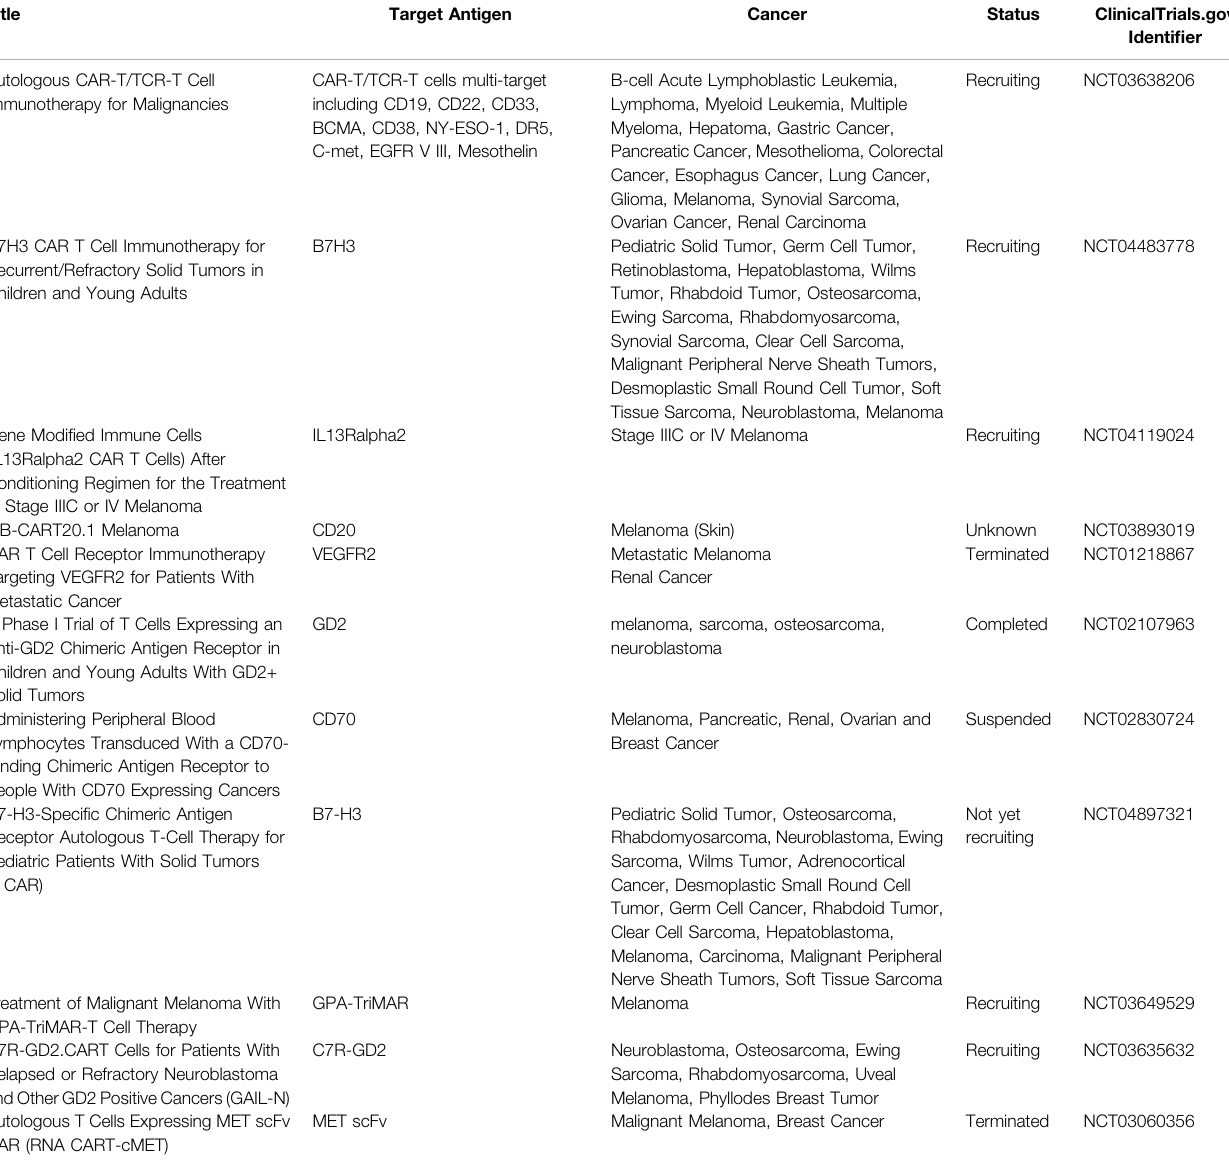
TABLE 2 | Clinical trials using CAR T-cells for the treatment of melanoma and other solid tumors. Target Antigen